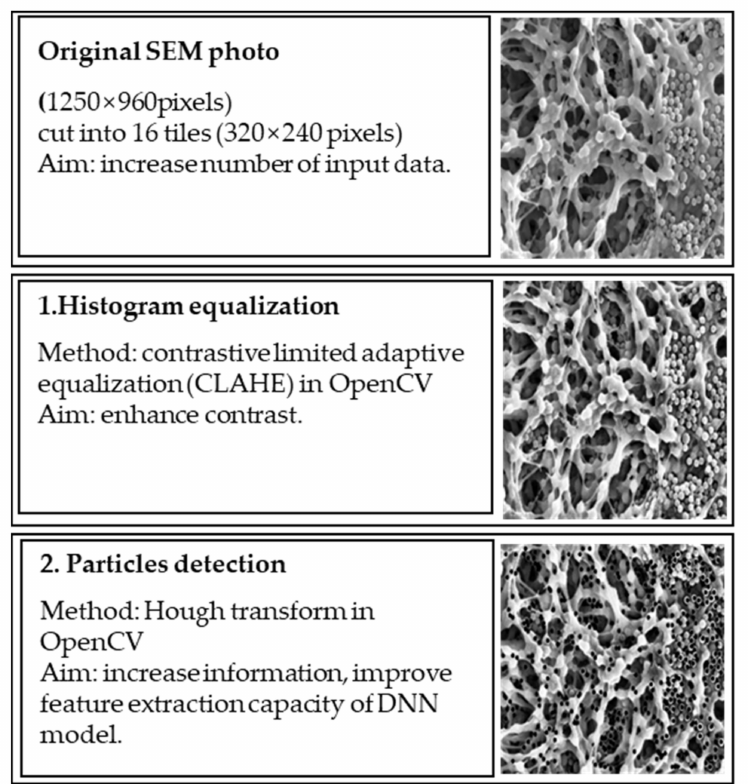
Figure A1. Image preprocessing steps